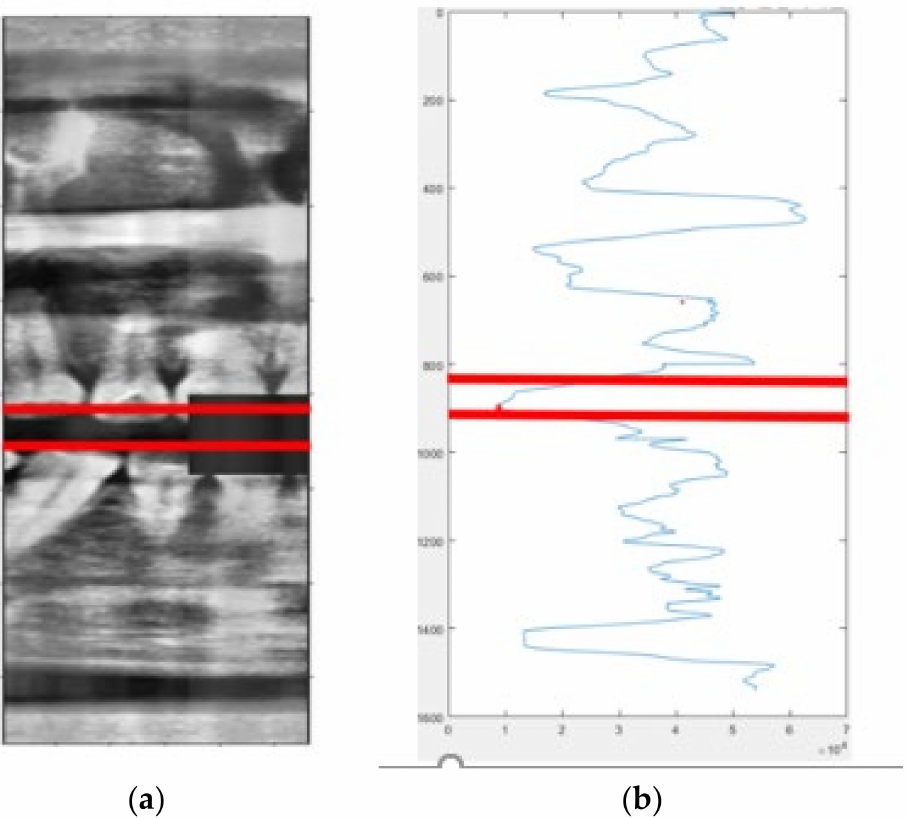
Figure 11. Cavity position. ( a ) The cavity position in X-ray and ( b ) the cavity position on the XY axis.